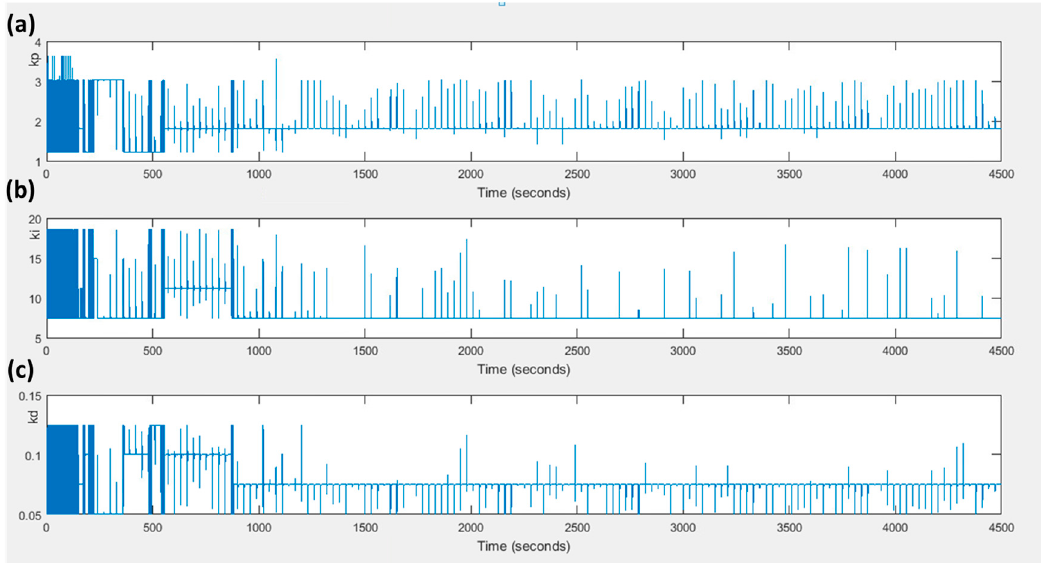
Figure 8. Values of ( a ) kp, ( b ) ki and ( c ) kd through the simulation.